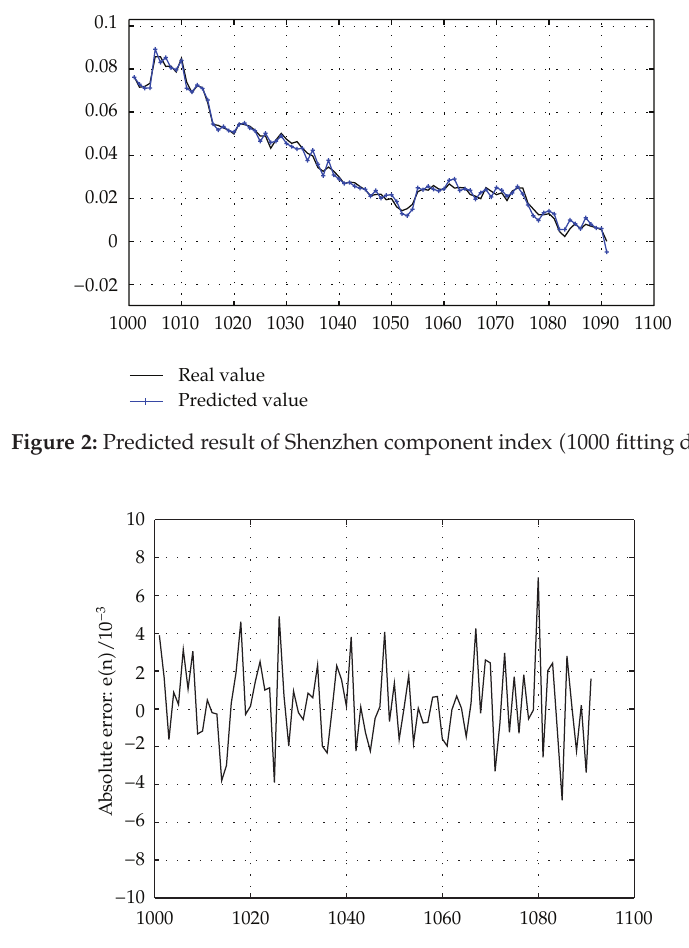
Figure 3: Absolute error of one-step prediction (cid:4) 1000 fitting data (cid:5)